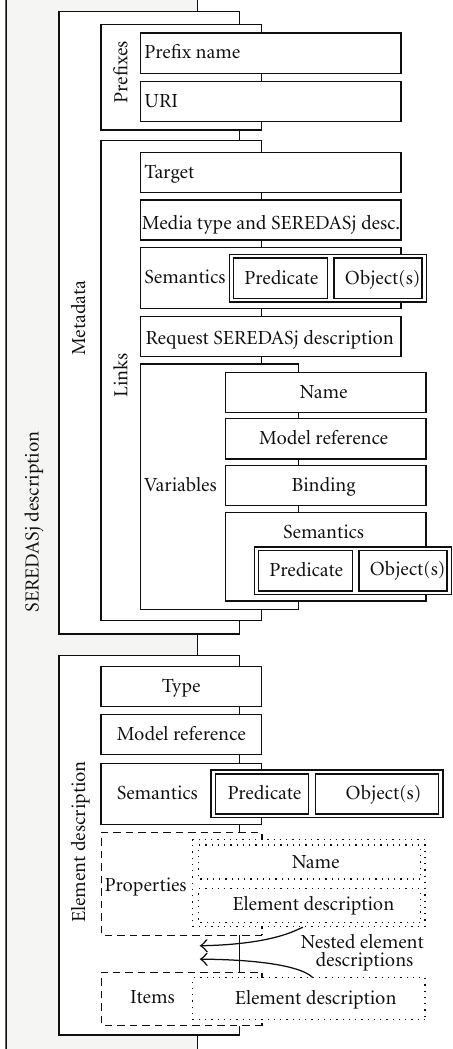
Figure 1: The SEREDASj description